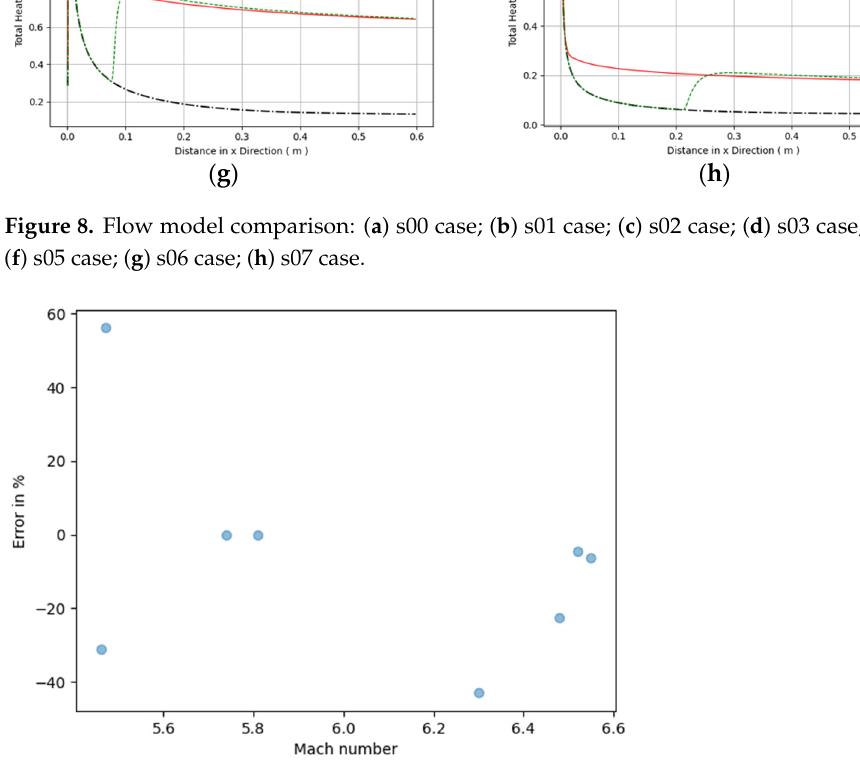
Figure 9. Error of different flow cases against Mach number. Table 7. Transition onset locations under different flow cases.